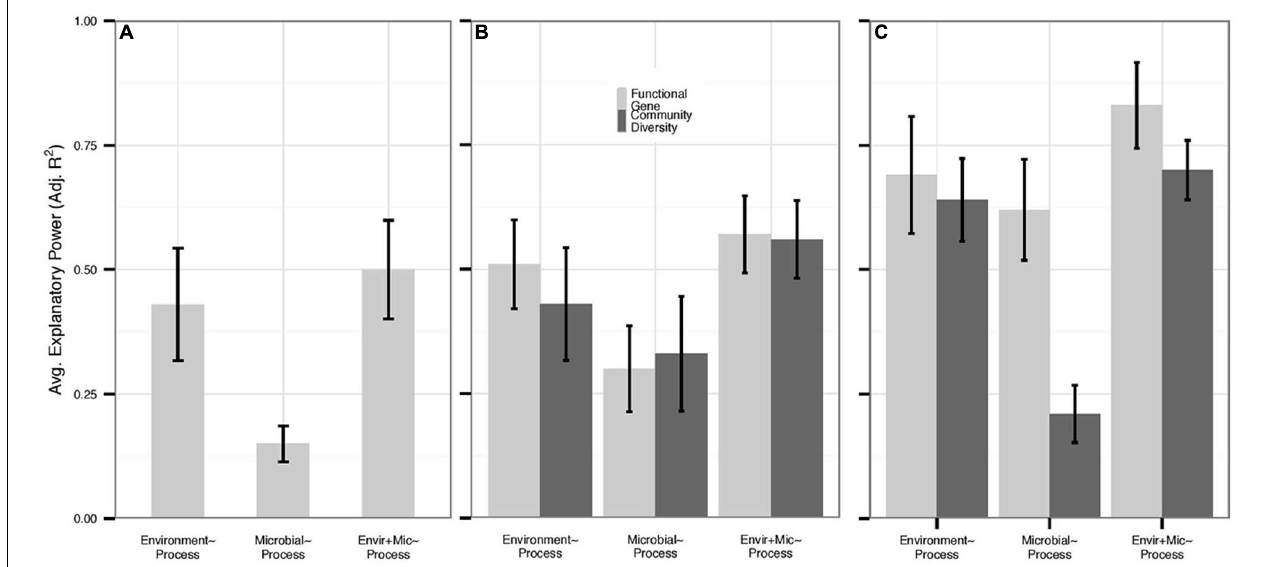
FIGURE 2 | Average explanatory power varied by process and microbial data type, and we present the explanatory power of functional genes (abundance and diversity) and community diversity for each N cycling process. Environmental model bars slightly differ within each figure as they represent only the environmental models for each data type, and functional genes are not depicted for N mineralization due to low sample size ( n = 2). Error bars represent standard errors. (A) N mineralization ( n = 12) and (B) denitrification ( n = 17) models had relatively low explanatory by all predictor sets. However, community diversity metrics ( n = 4) provided more added value for denitrification rates than for other processes. (C) By contrast, rates of nitrification ( n = 14) were well-explained by both environmental and functional gene predictor sets ( n = 6) and were more likely to be improved by functional